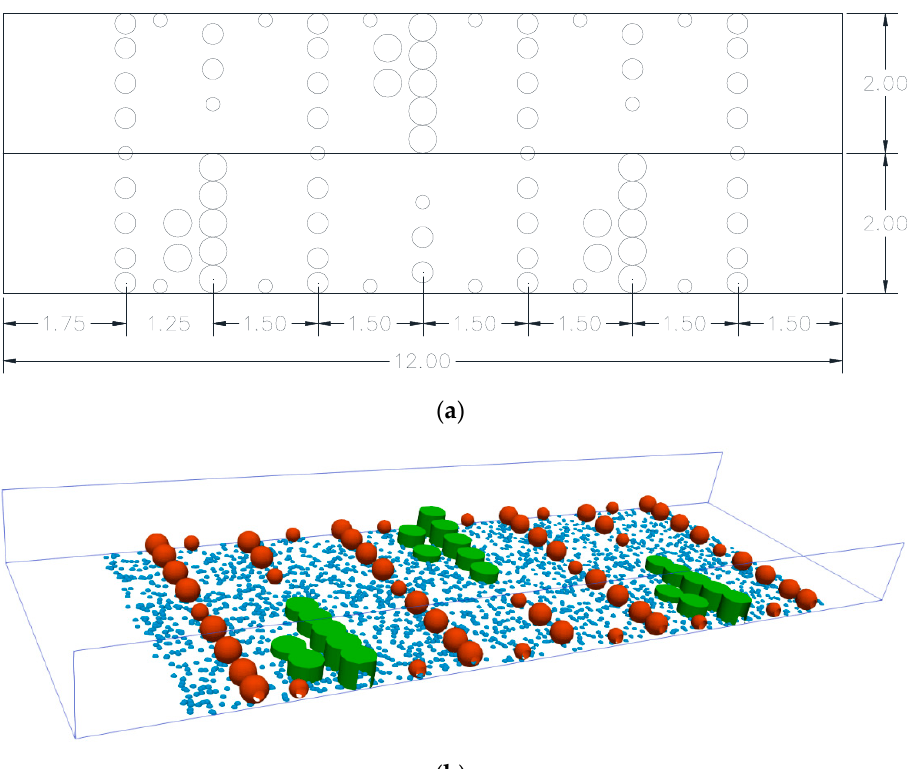
Figure 9. The model geometry ( a ) with a smooth bed (dimensions in meters) and ( b ) with bed roughness elements. Colors indicate bed roughness elements (blue), substrate spheres (red), and cylinders (green). Flow from left to right.